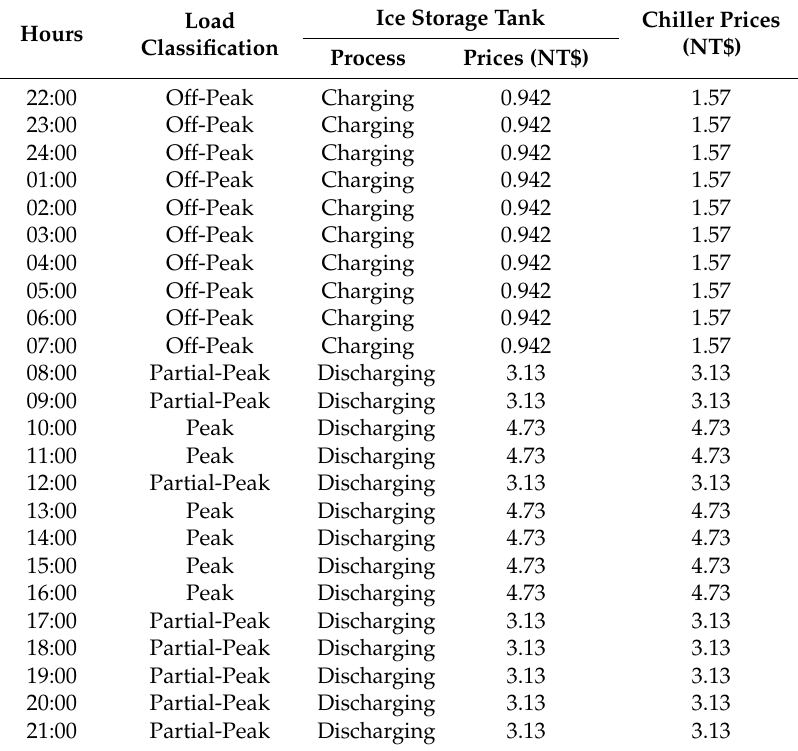
Table 1. The TOU [4] rate for a summer day.